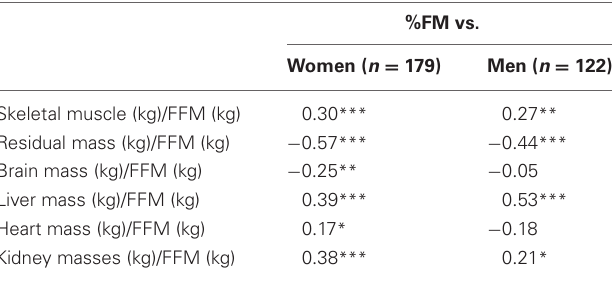
Table 6 | Coefficients of correlation between organ and tissue masses/FFM and adiposity (%FM) stratified by gender in study population